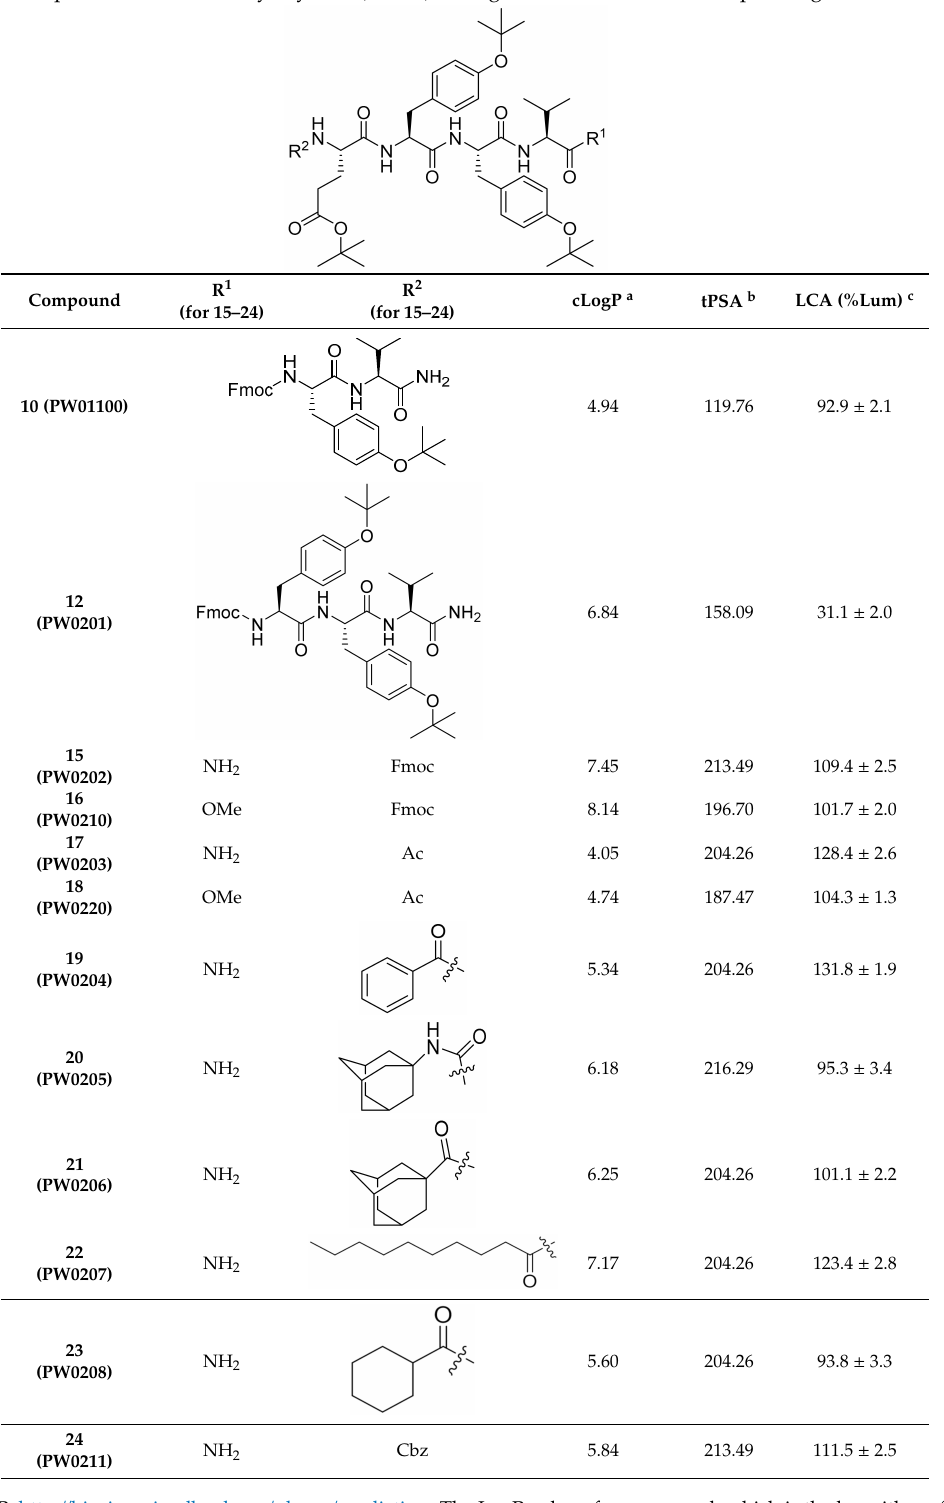
Table1. RepresentationofGlu-Tyr-Tyr-Val(EYYV)analogmodificationsandcorrespondingLCAresults. Table 1. Representation of Glu-Tyr-Tyr-Val (EYYV) analog modifications and corresponding LCA results.